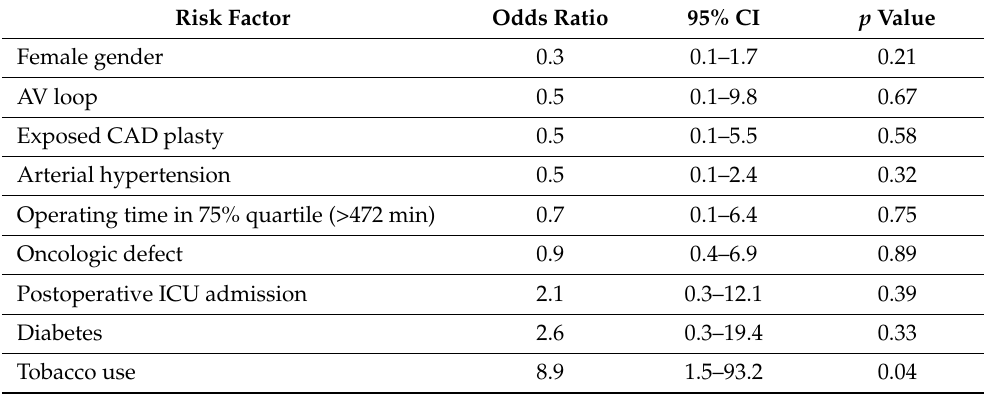
Table 5. Prognostic risk factor for major